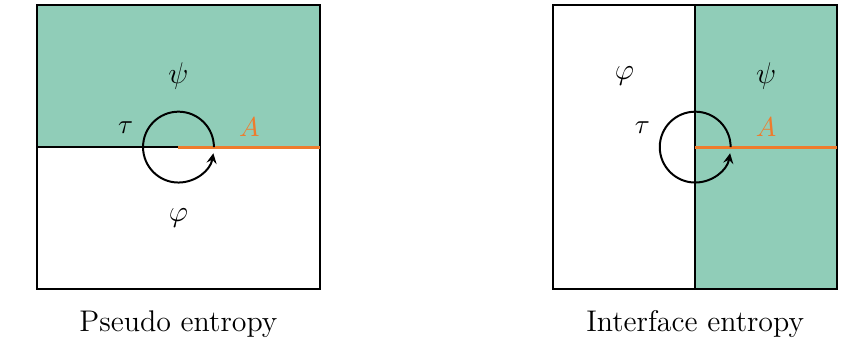
Figure 19 . The pseudo entropy and interface entropy across a hyperplane. Their replica manifolds are the same up to the τ shift by π/ 2